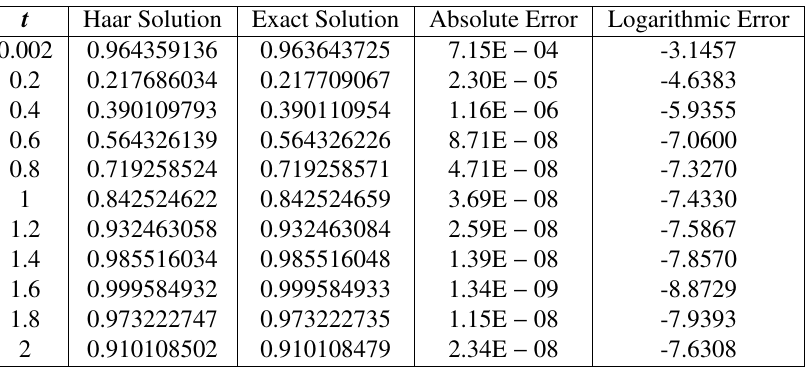
Table 1. Numerical results, exact solutions and errors for Example 1 for J = 8